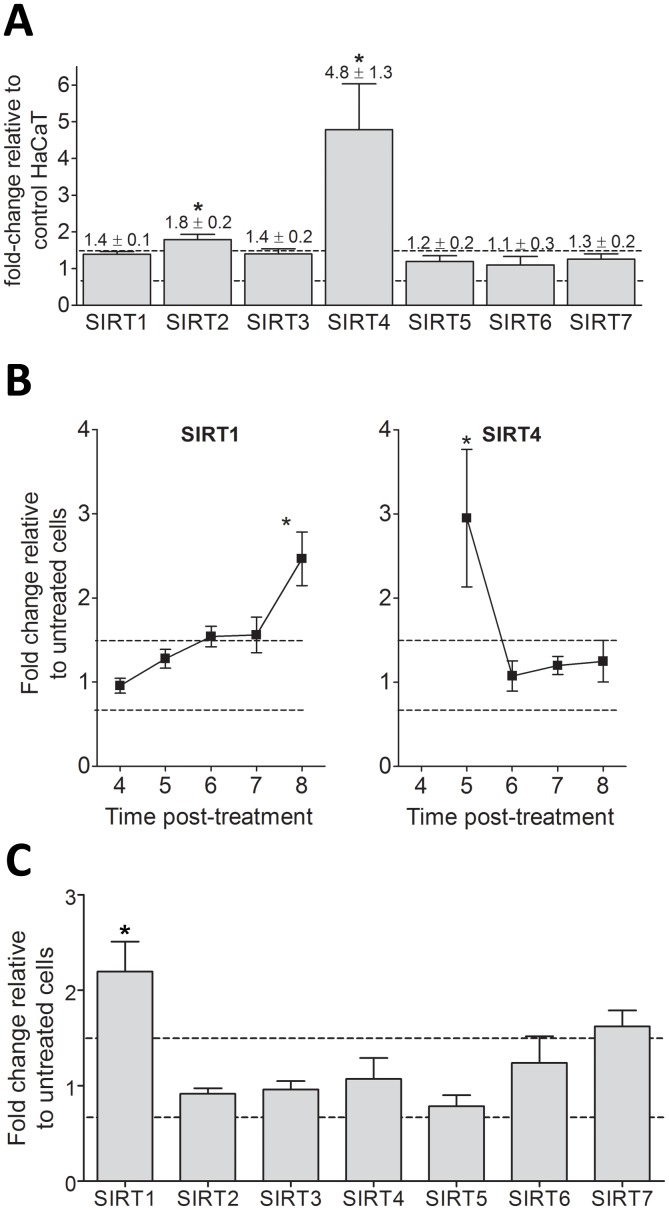
SIRT gene expression changes in HaCaT keratinocytes upon niacin restriction and photodamage.SIRT gene expression profiles in HaCaT keratinocytes were measured using qPCR. (A) Niacin-restricted SIRT gene message levels shown are expressed as fold-change relative to niacin replete HaCaTs. (B) Time course of SIRT1 and SIRT4 mRNA expression after SSL treatment. (C) Time course of SIRT gene expression after singlet oxygen stress. Expression levels shown for B and C are calculated as fold-change relative to untreated niacin-restricted HaCaTs. All samples were normalized to GAPDH gene expression. Mean ± SEM, n = 3 independent experiments with triplicate samples. *p<0.05 and a fold change >1.5 or <0.67 (dashed lines).